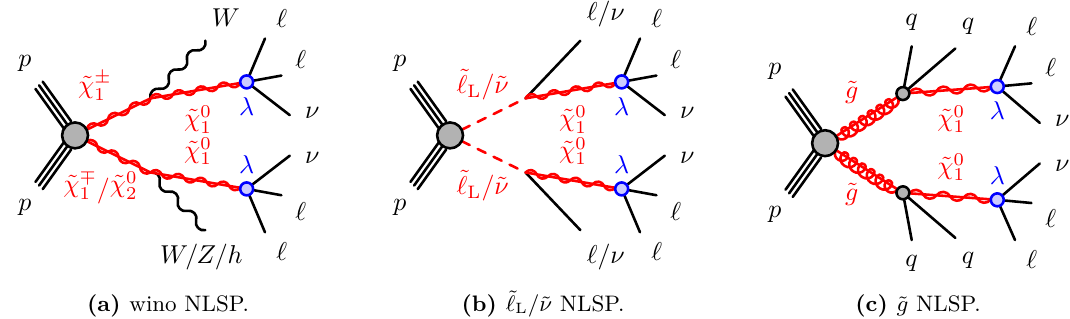
Figure 2. Diagrams of the benchmark SUSY models of RPC NLSP pair production of a (a) wino, (b) slepton/sneutrino and (c) gluino, followed by the RPV decay of the ˜ χ 0 to decay as ˜ χ 0 with 100% branching 1 → ‘‘ν